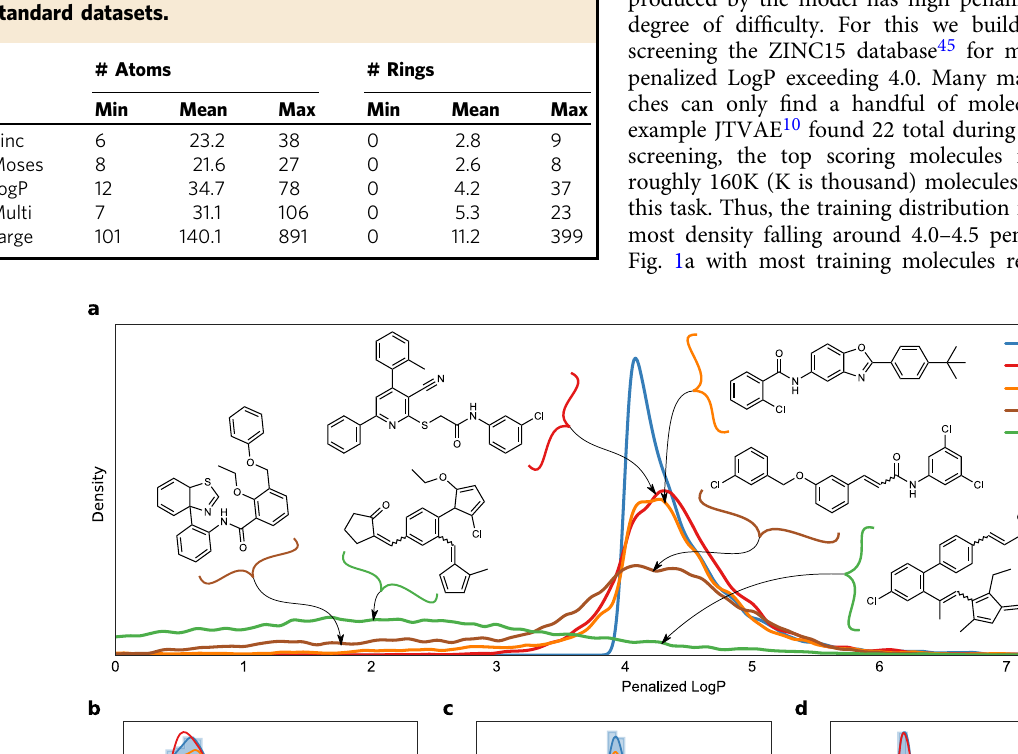
Table 1 Dataset statistics for all three tasks compared to standard datasets.